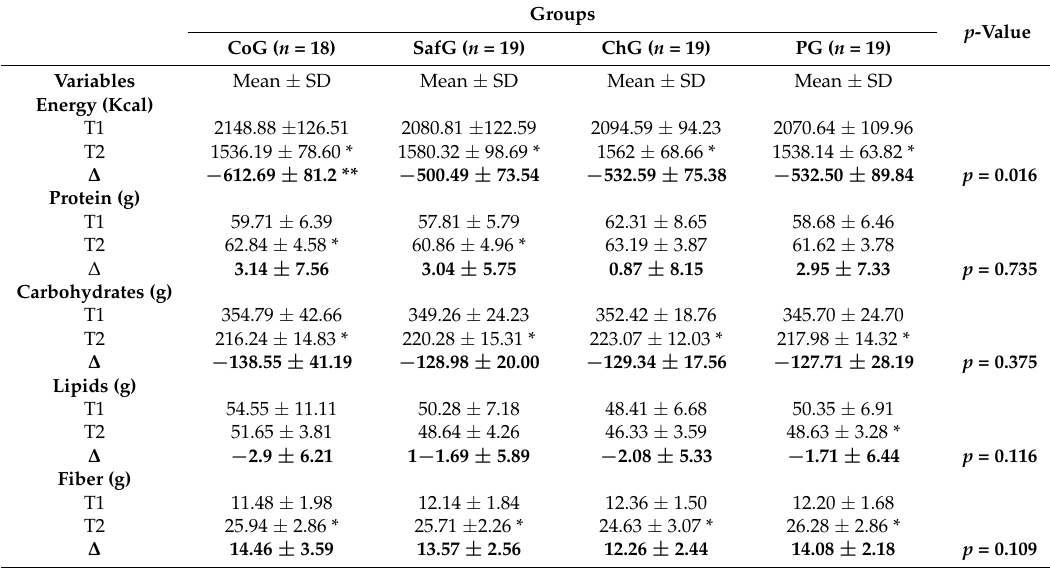
Food intake variation estimated of participants before (T1) and after (T2)